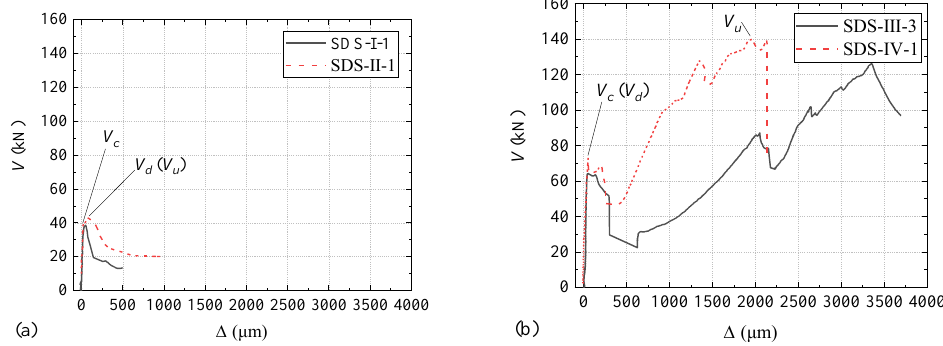
Figure 7. V- ∆ plots of SDS test for typical specimens: ( a ) Specimen SDS-I-1 and SDS-II-1; ( b ) Specimen SDS-III-3 and SDS-IV-1.